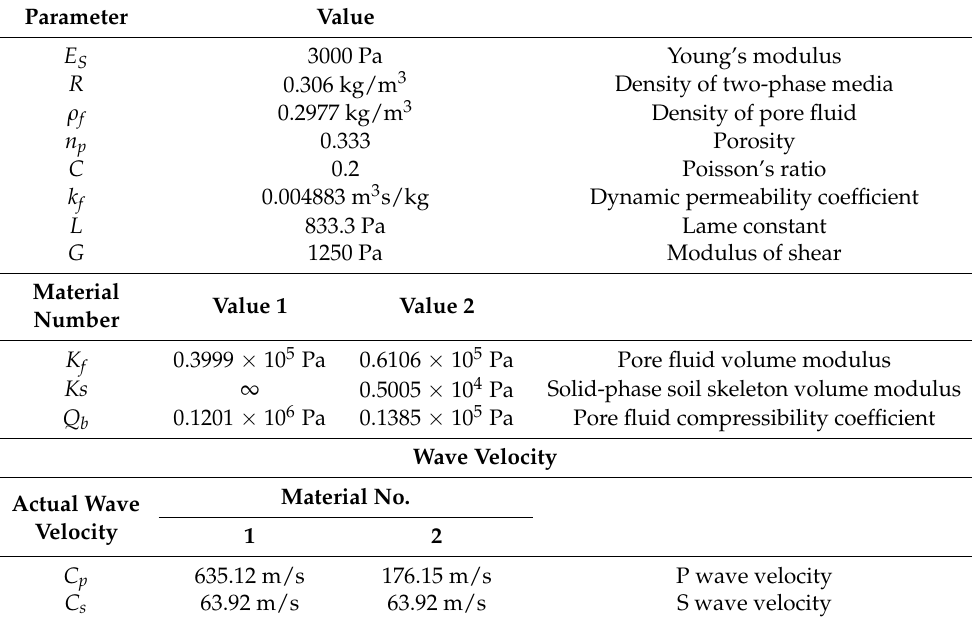
Table 1. Material parameters of the linear elastic saturated soil.